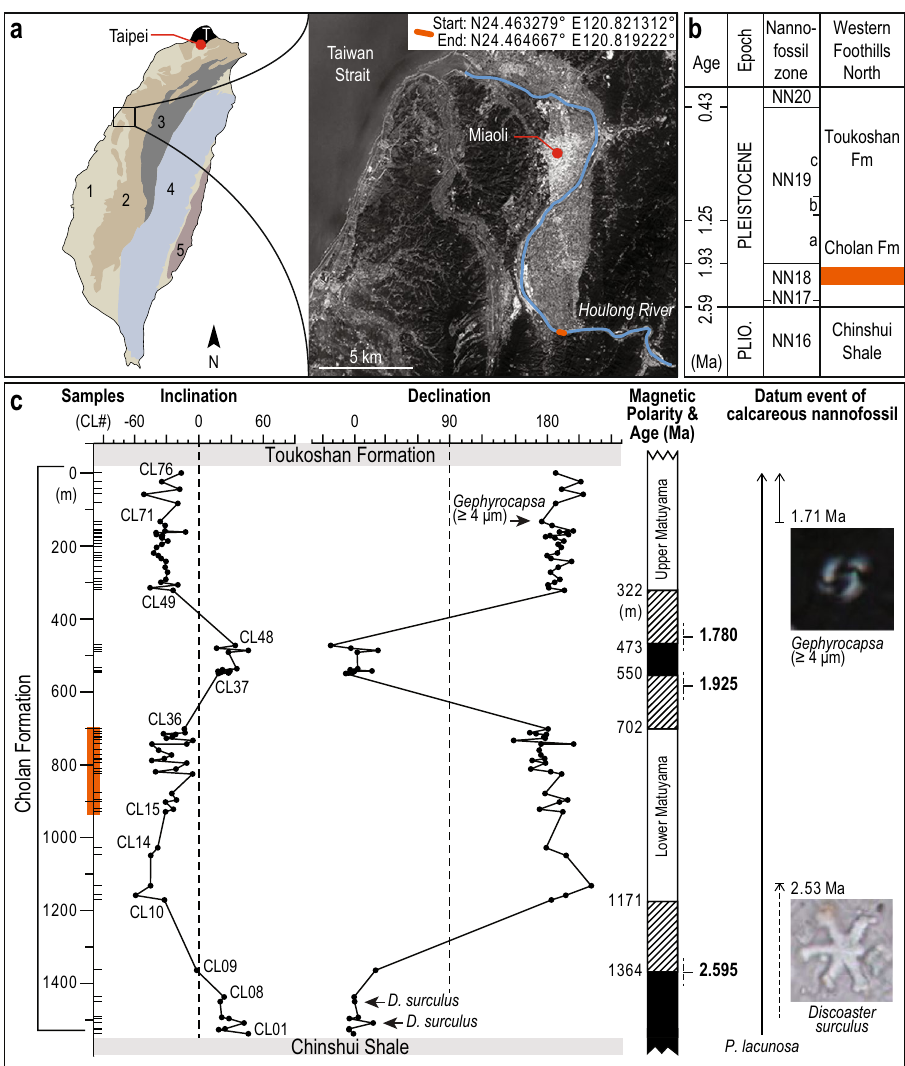
Figure 1. Geographic and stratigraphic framework. ( a ) Simplified geological map of Taiwan: 1—Coastal Plain; 2—Western Foothills; 3—Hsuehshan Range; 4—Central Range; 5—Coastal Range; T—Tatun volcano group (map modified from Lin and Chen 28 ). The studied section stretches along the Houlong River. The satellite map is from Google Earth. ( b ) The chronostratigraphic chart of the northern part of the Western Foothills 22 . ( c ) The magneto-biostratigraphic framework developed in this study places the studied section within the lower Matuyama reversed epoch close to the lower limit of the Olduvai normal polarity subchron. The intense vegetation cover on the outcrop presently prevents sampling near the polarity boundaries (hatched intervals in the Magnetic Polarity & Age (Ma) column). The geomagnetic polarity time scale 29 and the datum events of index calcareous nannofossils 30 are shown. Ol: Olduvai. Orange lines denote the studied stratigraphic interval. The illustration was made using Adobe Illustrator CS6 (https:// www. adobe.